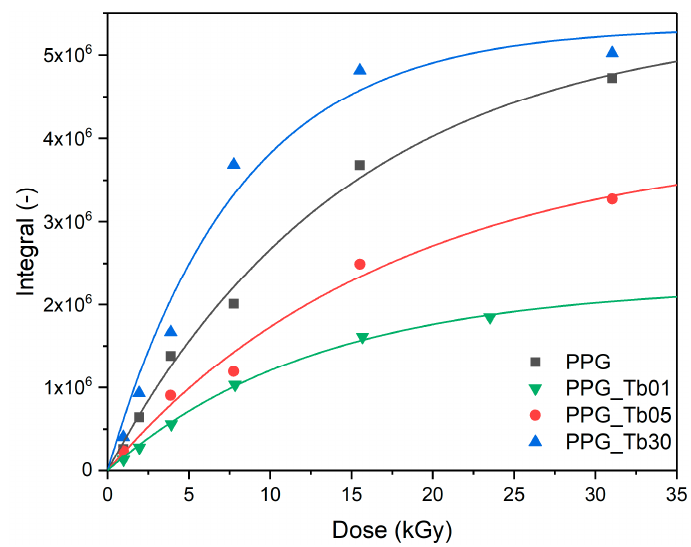
Figure 3. Dependencies of TL signal integral vs. dose absorbed for glass dosimeter irradiated with beta radiation (4 μ s); for PPG sample, TL glow curves were recorded without shutter.